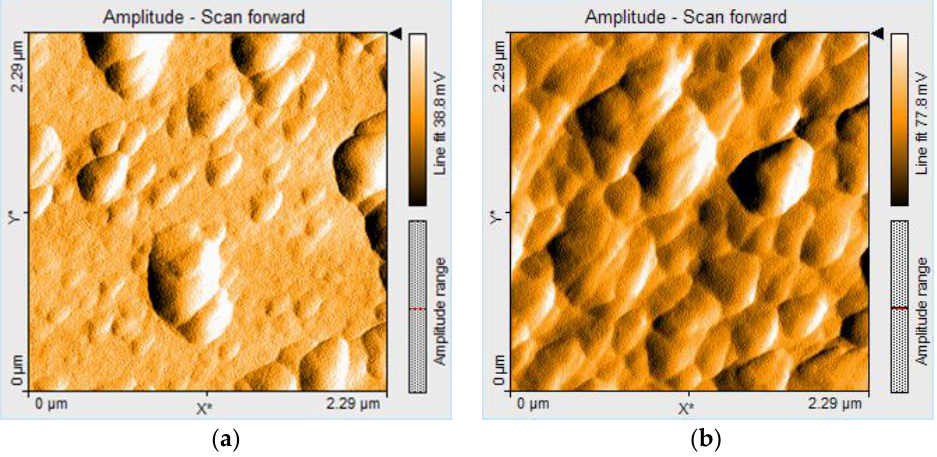
Figure 7. 2D AFM images of TAPP ( a ) its ZnTAPP derivative ( b ) and from THF solvent